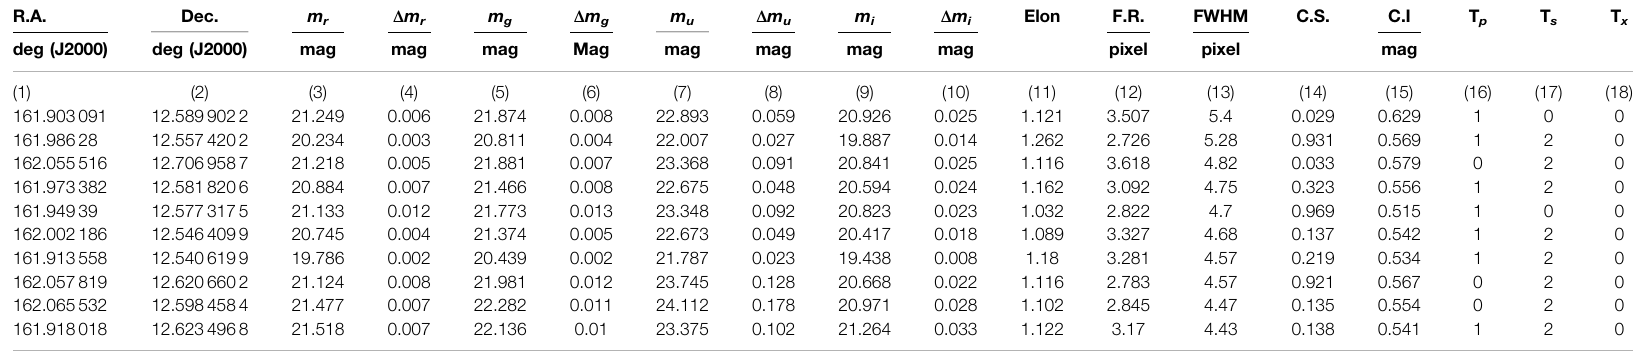
TABLE 4 | Master catalog parameter: Col. (1-2) R.A and Dec. in degrees (J2000), Col. (3-4) magnitudes and uncertainties in the r band,Col. (5-6) magnitudes and uncertainties in the g band, Col. (7-8) magnitudes and uncertainties inthe u , Col.(9-10) magnitudes and uncertainties inthe i band, Col.11) istheElongation parameter from SExtractor de fi ned asthe ratiobetween themajor and minor axis ofthe sources, Col.12) istheFlux RadiusparameterfromSExtractorwhichistheradiuscontaininghalfofthe fl uxfromthesources,Col.13)istheFWHMparameterfromSExtractor,Col.14)istheClassStarparameterfromSExtractorwhichclassifysources, Col. 15) is the Concentration Index de fi ned as the difference between magnitude at difference aperture, in particular we did the difference between 4-pixel aperture magnitude and 6-pixel one. Col. (16-18) refer to literature classi fi cations of globular cluster, T p stand for photometric, T s stands for spettroscopy, T x stand for LMXB studies. The full table is available at the VEGAS project web pages, and in the CDS repository.